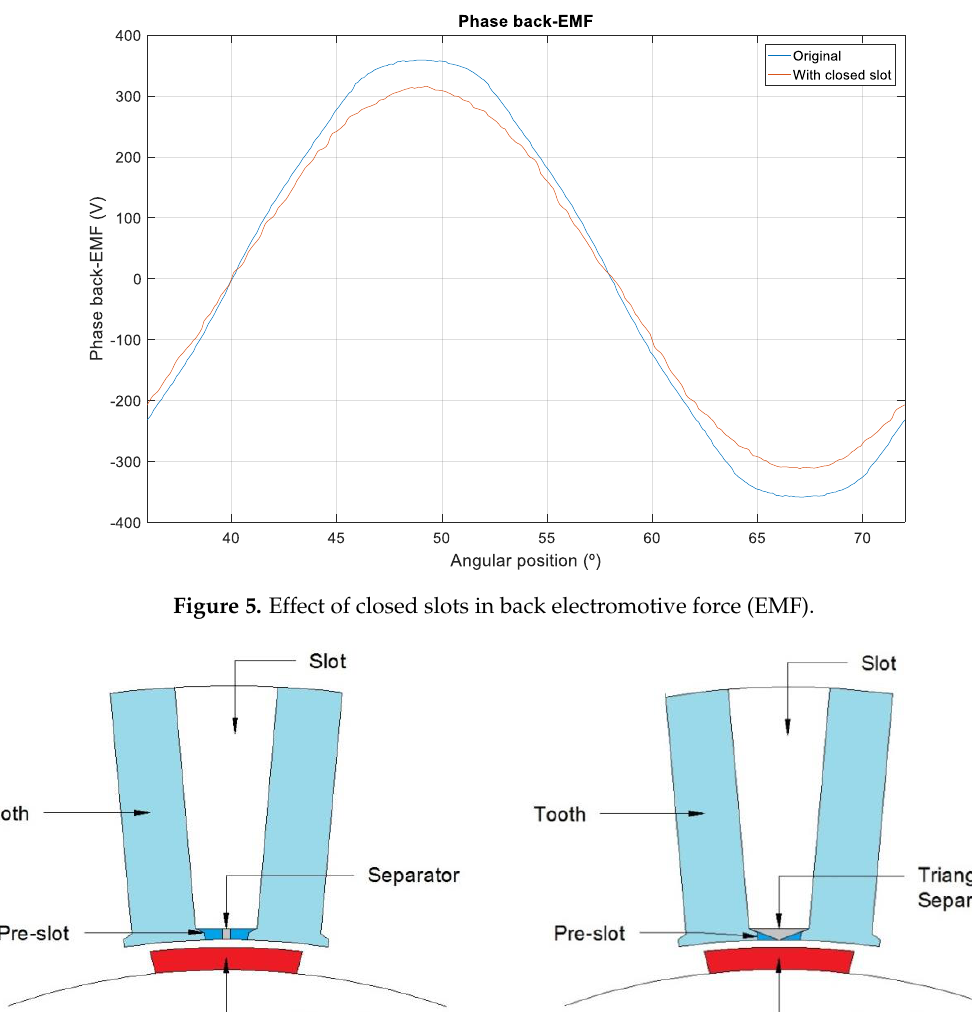
Figure 7. Comparison of cogging torque reduction with pre-slot method.